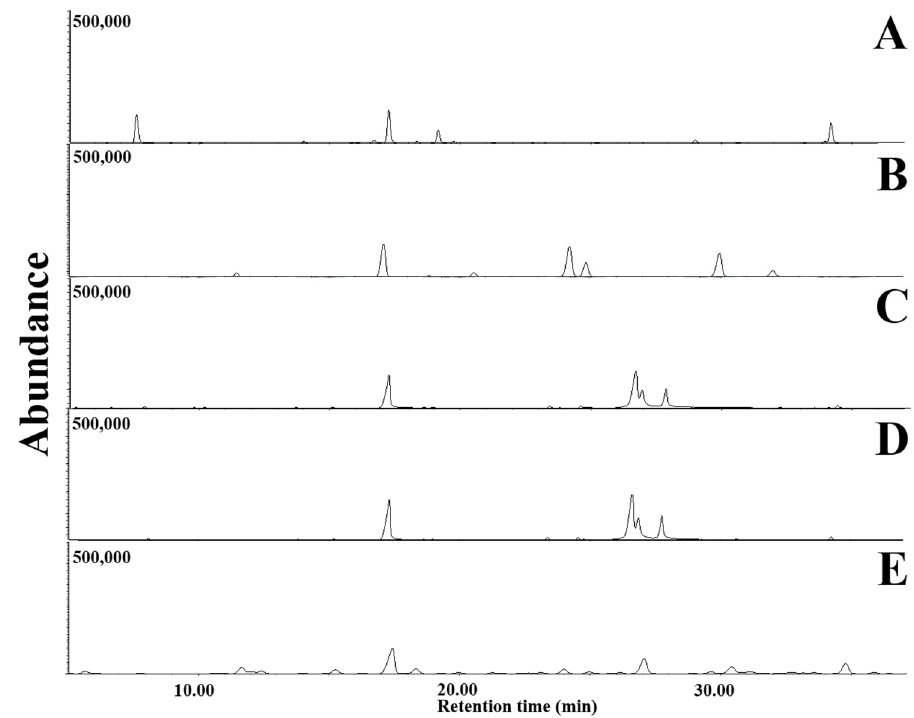
Figure 9. GC-MS chromatograms of dichloromethane extracts of LDPE films cultured with T. jaczewskii ( A ), S. citrulli ( B ), A. niger ( C ), D. italiana ( D ), and C. fructicola ( E ) after 30 days of incubation, respectively.